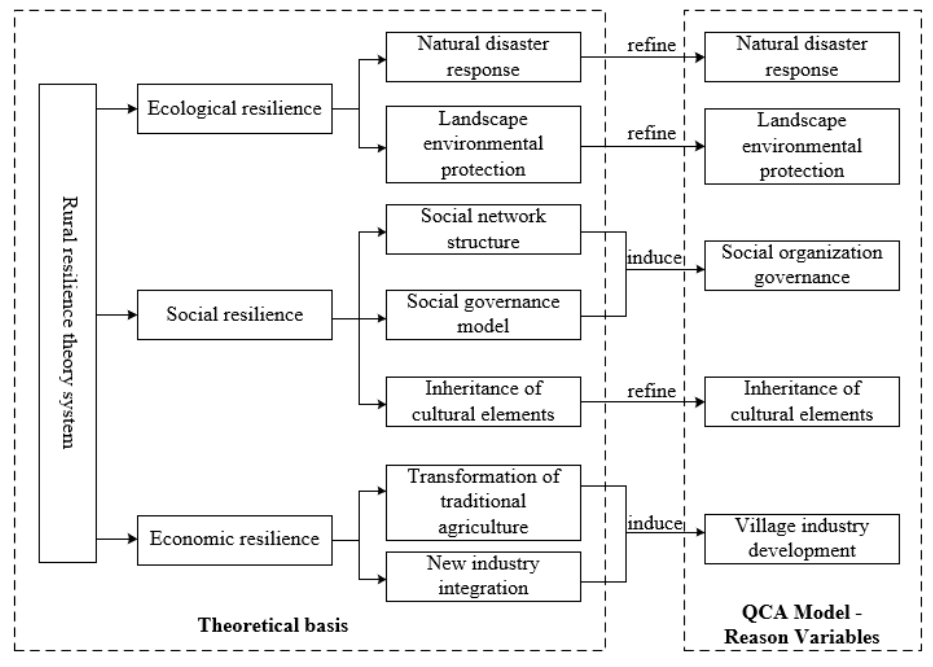
Figure 4. Cause variable selection. Table 2. Corresponding relationship between condition quantity of variables and sample quantity for QCA of fuzzy sets.